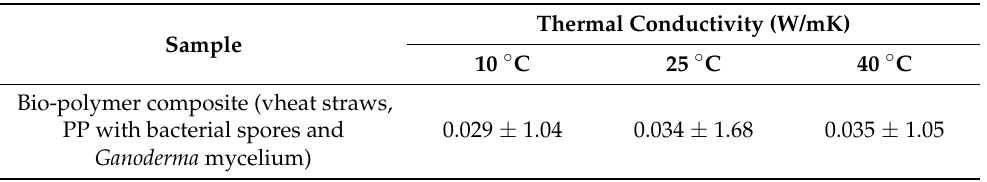
Table 2. Thermal conductivity of bio-polymer